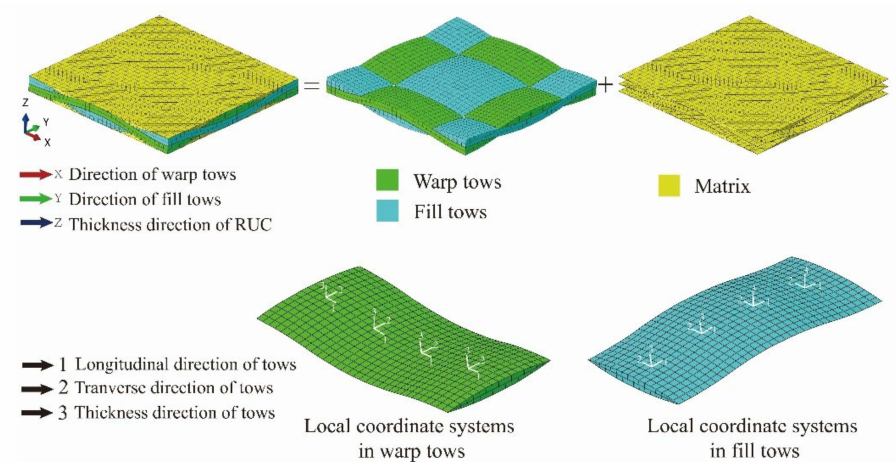
Figure 3. The meso-scale RUC of the plain-woven fabric composites. With the macro-scale stresses similar to Figure 2 and the unit temperature increment applied on the meso-scale RUC, the corresponding meso-scale stresses at the reference points in Figure 4 can be obtained. The SAFs of M t and A t in the region of fiber tows and the SAFs of M m and A m in the region of the pure matrix could then be calculated, indicating the establishment of the transformation methods between the macro-scale stresses and the meso-scale stresses at the reference points in Figure 4.